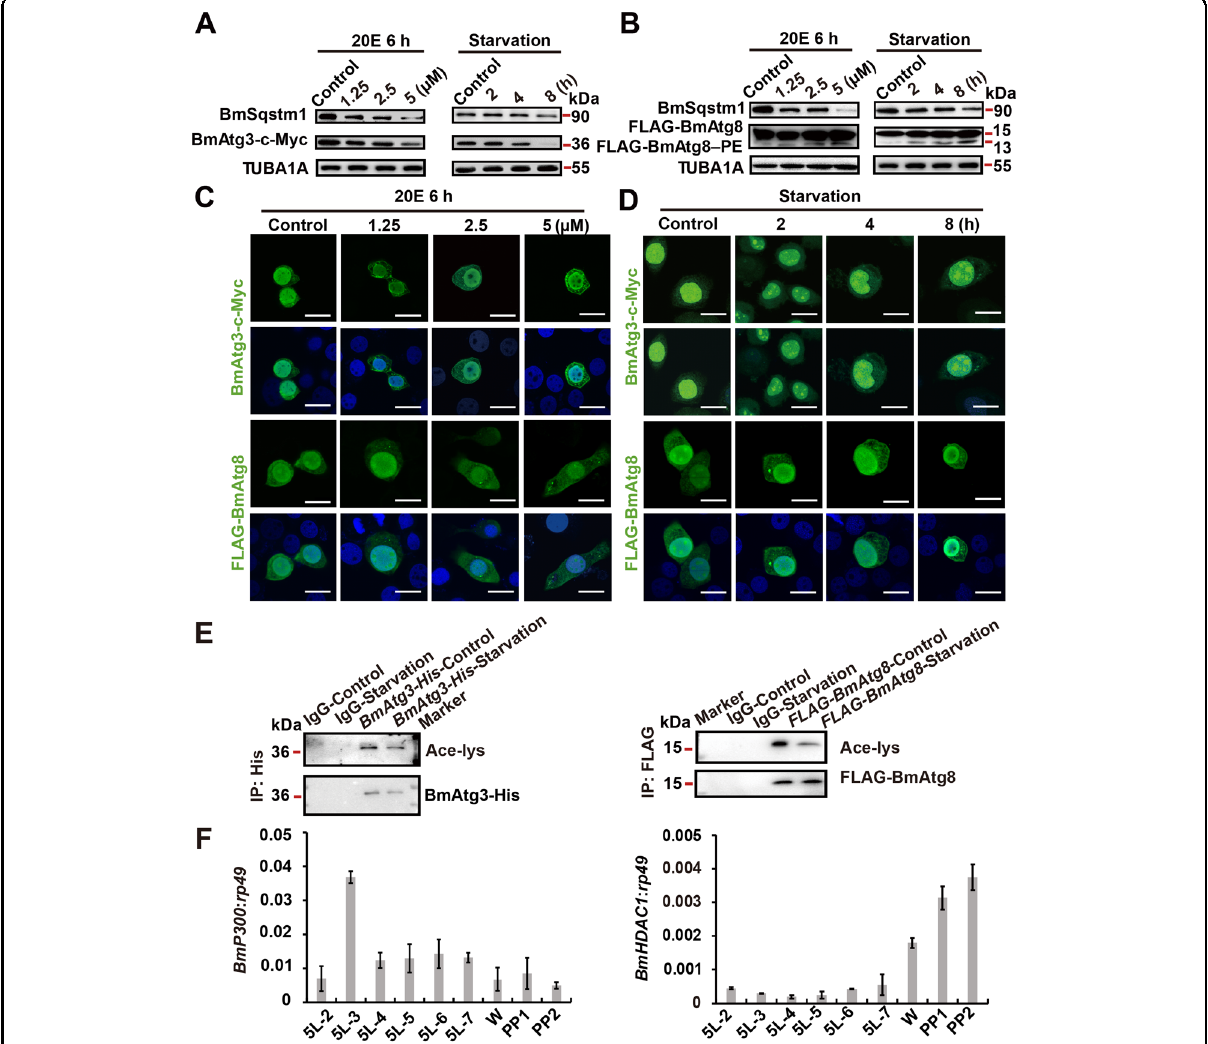
BmAtg8 in FLAG-BmAtg8- overexpressing BmN cells treated with 1, 2.5, and 5 μ M 20E for 6 h or 2, 4, and 8 h starvation. C Immuno fl uorescent staining of BmAtg3-c-Myc and FLAG-BmAtg8 after 1, 2.5, and 5 μ M 20E treatments for 6 h in BmN cells. Scale bar: 10 µm. D Immuno fl uorescent staining of BmAtg3-c-Myc and FLAG-BmAtg8 after 2, 4, or 8 h starvation in BmN cells. Scale bar: 10 µm. E Acetylation levels of BmAtg3 and BmAtg8 after starvation for 4 h. F Transcriptional levels of acetyltransferases BmP300 and deacetylase BmHDAC1 in B. mori fat body from 5L2D to PP2